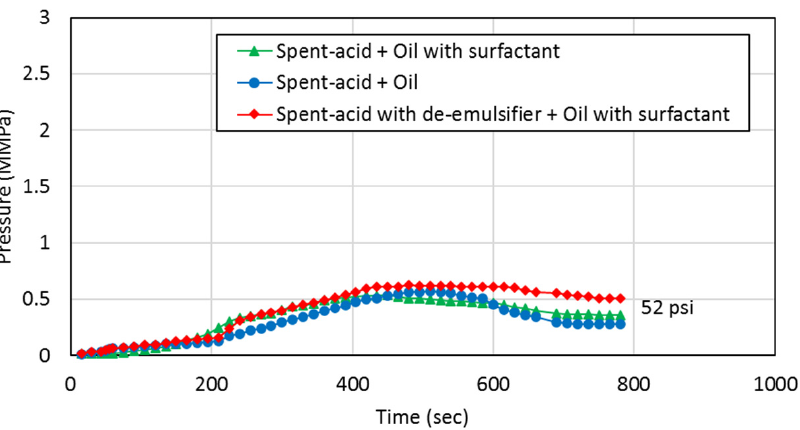
Figure 9. Pressure responses from the three scenarios when oil was injected at the inlet of the oil- saturated core before spent-acid was